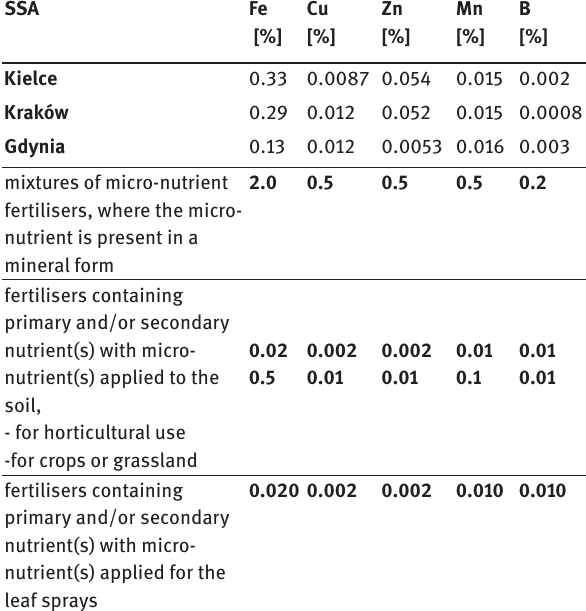
Table 7: Minimum concentration of the micro-nutrients in fluid fertilizers according to Regulation (EC) No 2003/2003 of the European Parliament and to the Council relating to fertilizers with respect to the extract